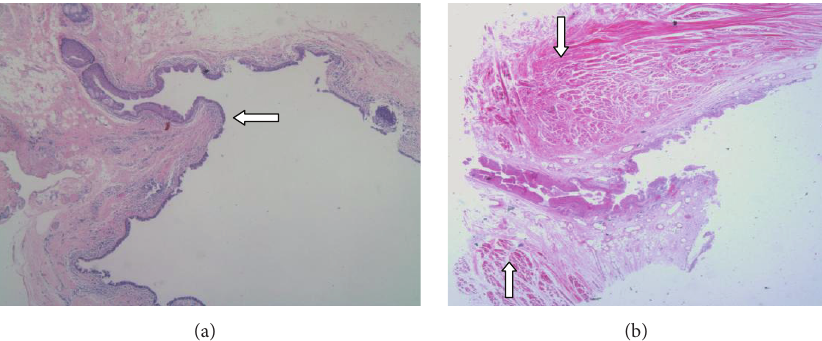
Figure 3: H&E staining of canalicular entrance into the lacrimal sac. (a) shows a protruding mucosal fold at the entrance of a common canaliculus to the lacrimal sac, which is covered with epithelial cells of saccus lacrimalis (arrow). The arrows in (b) show many bundles of circular and longitudinal muscles around this